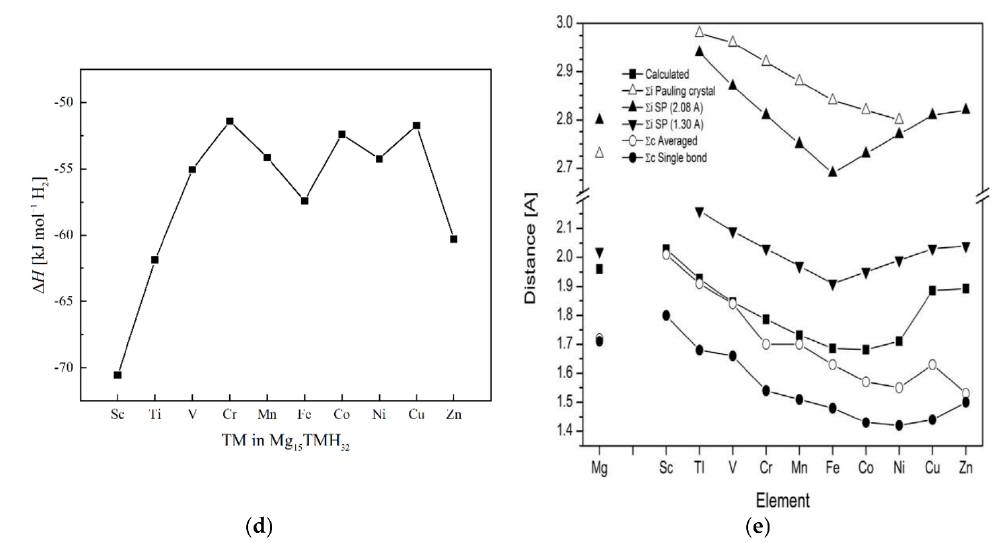
Figure 8. ( a ) Nearest (nn) and next-nearest neighbor (nnn) atoms of TM, with their coordination polyhedra, side perspective view (left), and top view (right). ( b ) Relaxed interatomic distances in TM-doped MgH 2 (Mg 15 TMH 32 system) obtained using Abinit PAW formalism. The nearest neighbor H (nnH) atoms forming the first coordination octahedron are marked as two top and bottom H2 and four coplanar H4 atoms. nnnMg are the nearest and the next nearest Mg atom, while nnnH1 and nnnH2 stand for the next-nearest neighbor H atom. Corresponding experimental and calculated values for pure MgH 2 are given on the left. Dashed lines represent the Mg–nnH (H2 and H4) average relaxed distance in pure MgH 2 compound. ( c ) Top—BEC on TM and nnH atoms for MgH 2 (left) and entire MgH 2 :TM series. Positive values correspond to charge depletion. Bottom—charge densities ( ρ b ) at the specific bonding critical points (bCPs) between TM and nnH atoms (b1), nnH, and nnnMg (b2) and nnnMg and nnnH (b3), corresponding to the first, second, and third coordination of TM. The corresponding ρ b value in MgH 2 is given for comparison on the left. ( d ) Enthalpy of formation of Mg 15 TMH 32 . The values come from Table 2, from the work of Mamula and coresearchers. ( e ) Bond distances obtained from Mg 15 TMH 32 structures relaxation (calculated) and by summing Pauling crystal and Shannon–Prewitt (SP) effective ionic ( Σ i ), averaged, and single-bond (SB) covalent radii ( Σ c ). 2.08 Å and 1.30 Å are used as H − effective ionic radii. ( a – e ) Reproduced with permission [28]. Copyright 2014,